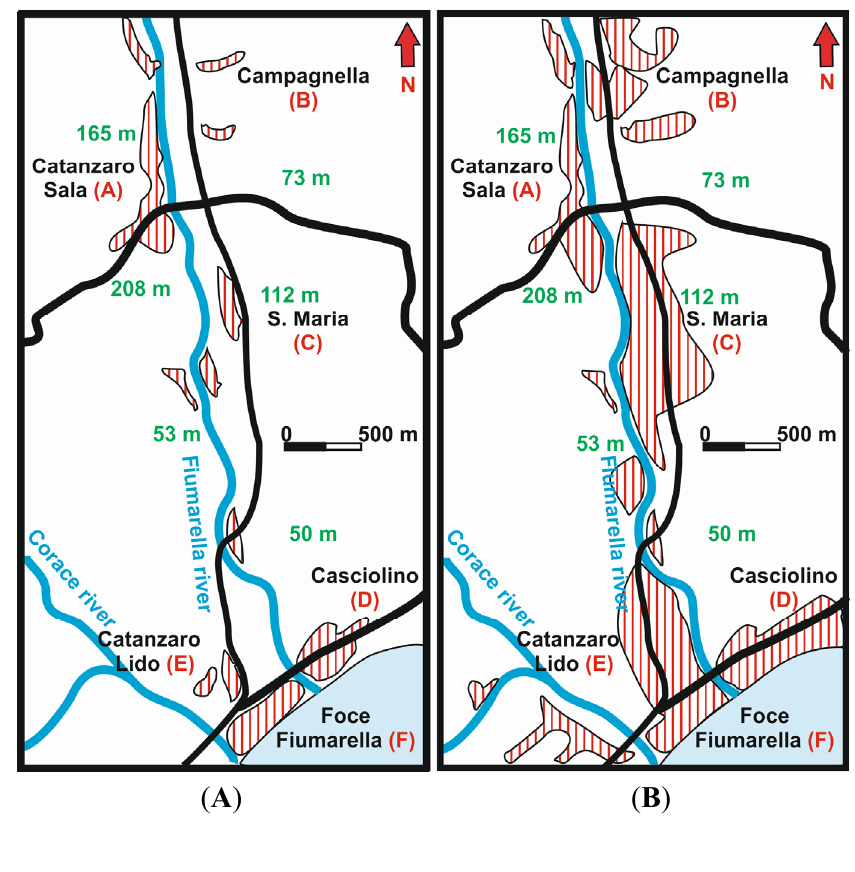
Figure 9. Evolution of urbanized areas (striped areas) in the Catanzaro, from ( A ) 1940 to ( B ) 1990 (IGM maps 1940 and 1990). Black and blue lines are roads and rivers,